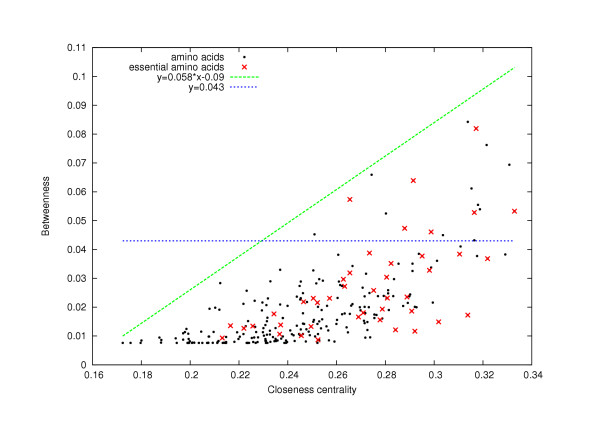
Relationship between the betweenness and the closeness centrality for TEM1 beta-lactamase. For each amino acid of TEM1 beta-lactamase, we plot the betweenness versus the closeness centrality. We notice that the points are not approximately disposed along a "natural curve", which suggests that there is no natural "functional relationship" between these two centrality measurements. Therefore, we cannot deduce one centrality measurement from the other one. However, we notice that the cloud of points is located under the curve "y = 0.058x-0.09". This implies that the set of amino acids with the highest betwenness is included in a set of amino acids with highest closeness centrality (for a given cut-off).